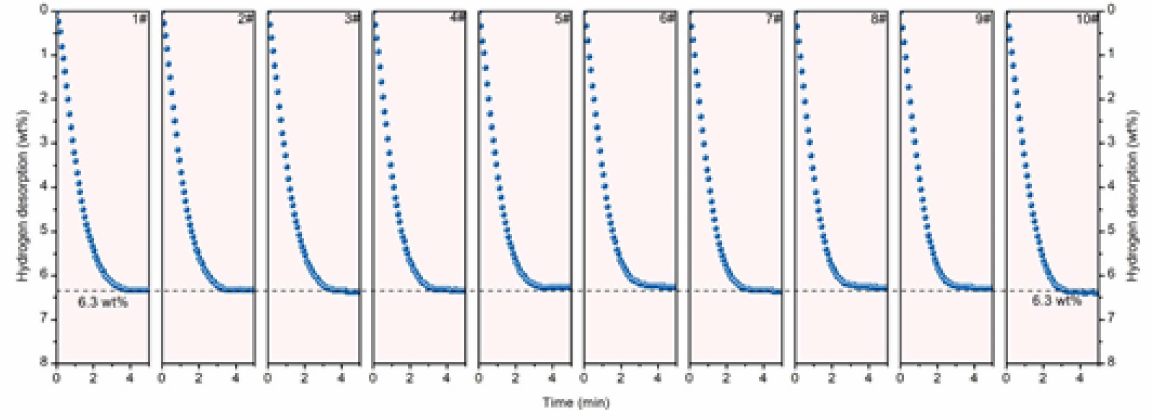
Figure 24. Cycling hydrogen desorption curves of MgH 2 –2V 2 C/Ti 3 C 2 at 300 ◦ C for up to 10 cycles [168]. (Reprinted with permission from the American Chemical